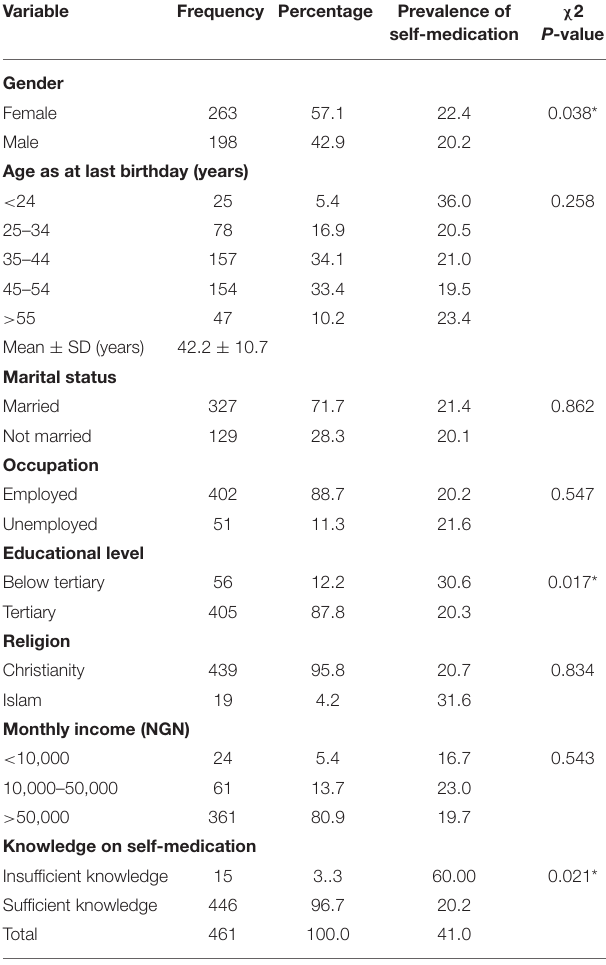
TABLE 1 | Characteristics of study participants and prevalence of